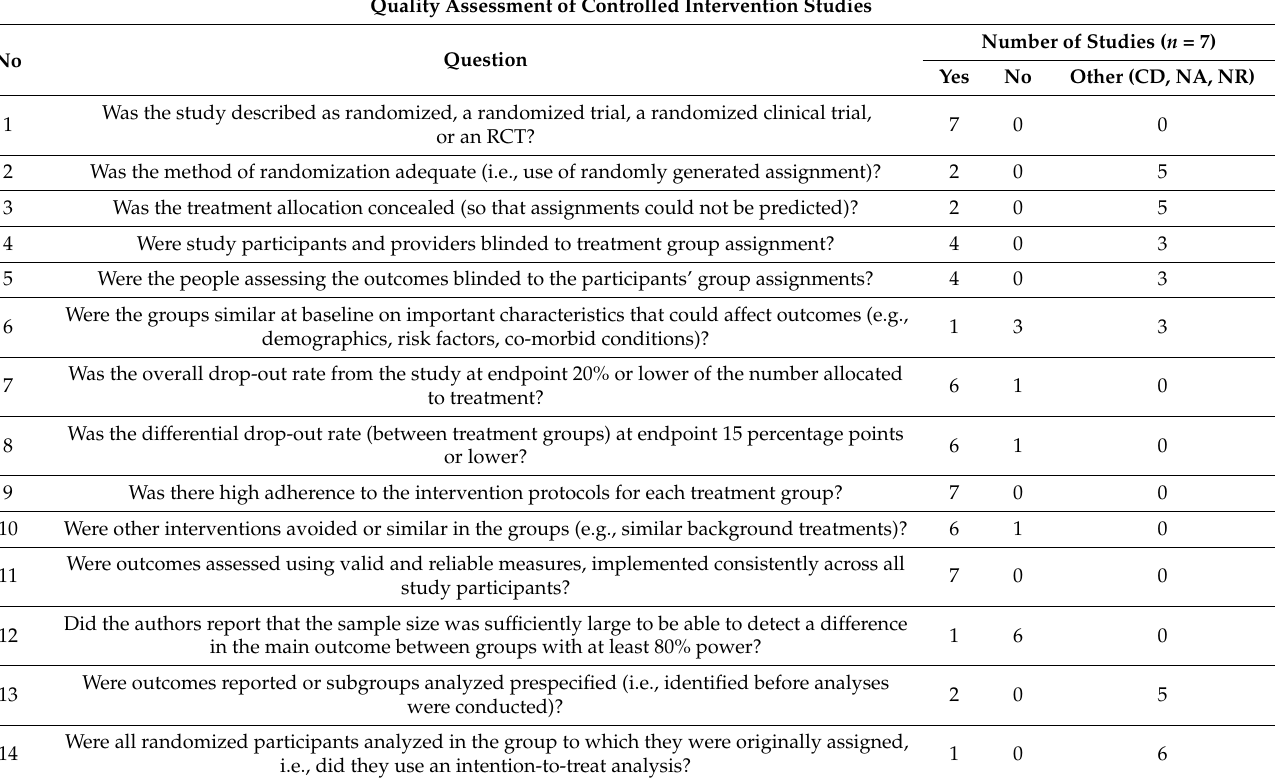
Table 2. Quality Assessment of Controlled Intervention Studies through National Heart, Lung, and Blood Institute (NHLBI) quality assessment